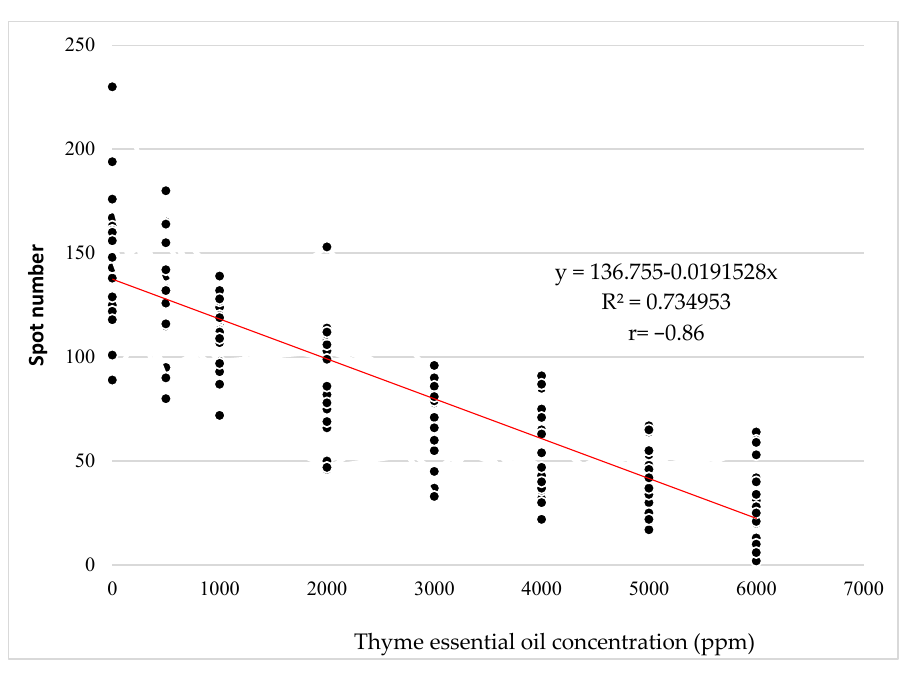
Table 4. Results of DAS ‐ ELISA for the Ch. quinoa plants inoculated with the CMV ‐ S21 isolate with the addition of thyme EO at different times of treatment.